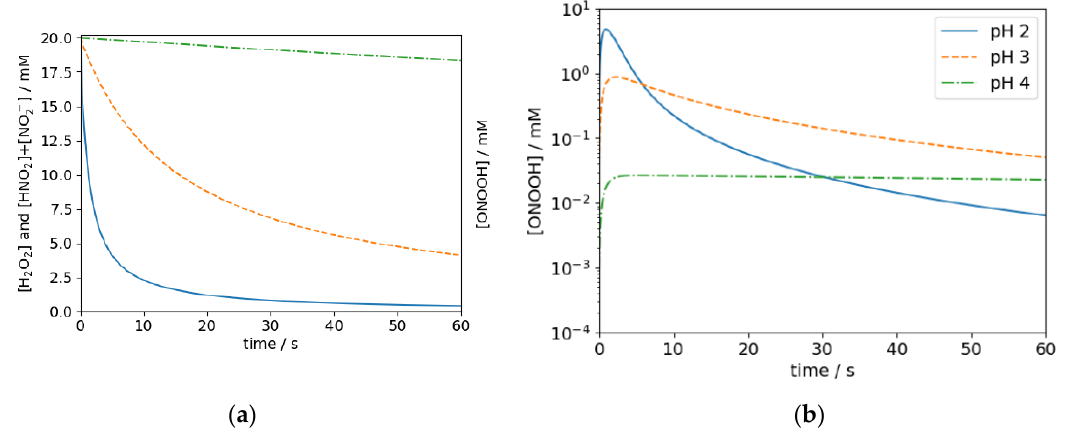
Figure 1. Time dependence of the concentration of the educts H 2 O 2 and HNO 2 ( a ) and resulting concentration of ONOOH at pH 2, 3, and 4 ( b ). The data is obtained by numerically solving the rate equations for reactions R1, R2, and R3.